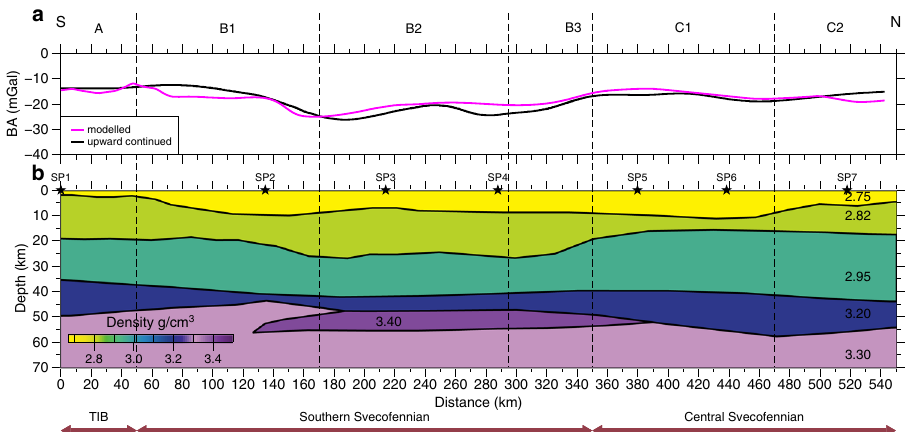
Fig. 7 Gravity model along the UPPLAND seismic pro fi le. Calculated gravity compared to EGM2008 gravity data 68 a for the density model b based on the velocity model (Fig. 2). Gravity data are 50 km upward continued to fi lter short-wavelength shallow structures. The correlation between the calculated and observed data supports interpretations of the velocity model.